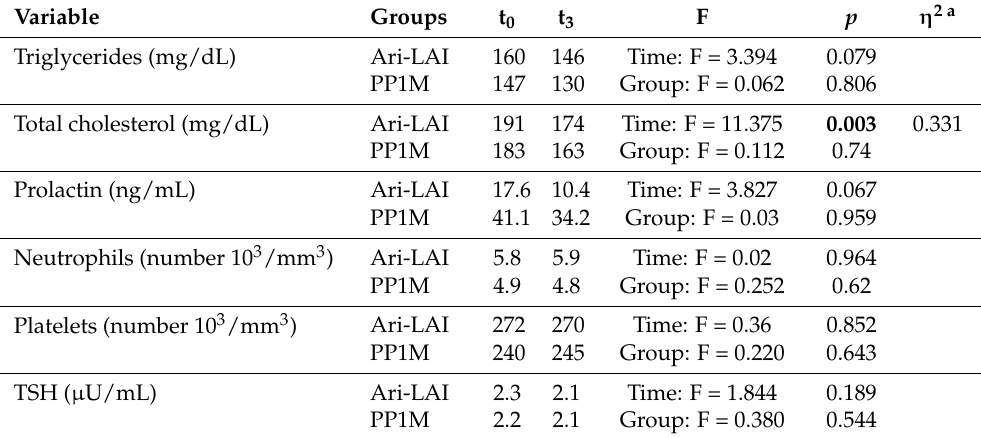
Table 3. General Linear Model repeated measures of the metabolic variables.